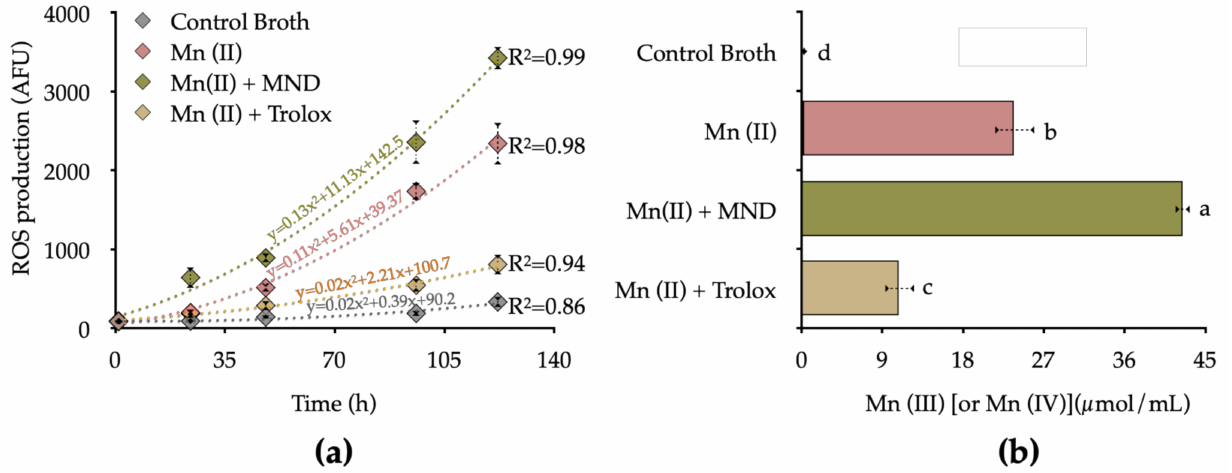
Figure 5. Influence of ROS production/scavenging on Manganese oxide production. ( a ) A. oxydans strains cultured in Mn-enriched broth (Control) supplemented with Mn(II), menadione (MND) as ROS stimulator, and Trolox as ROS scavenger at 15 ◦ C after 120 h of incubation. ( b ) Mn(III/IV) production at 120 h of incubation. Different letters show significant differences with p < 0.05. Data were plotted using a second-order polynomial (quadratic)